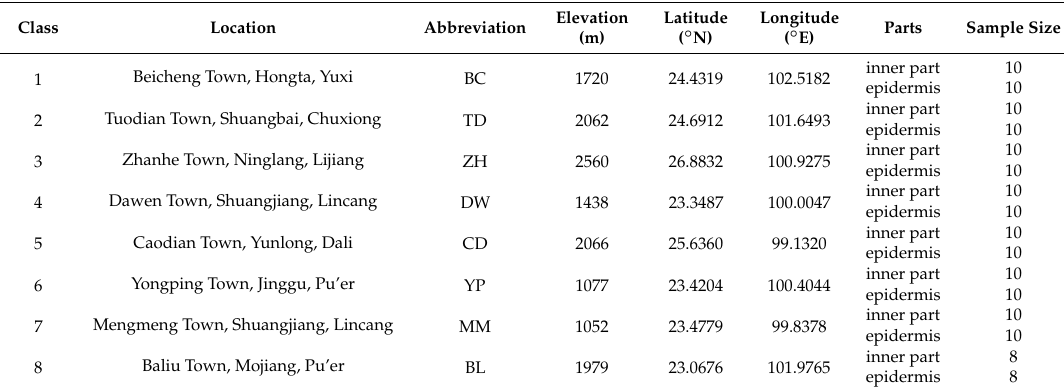
Figure 6. Dried sclerotium of M. cocos . Table 2. The information of M. cocos samples.